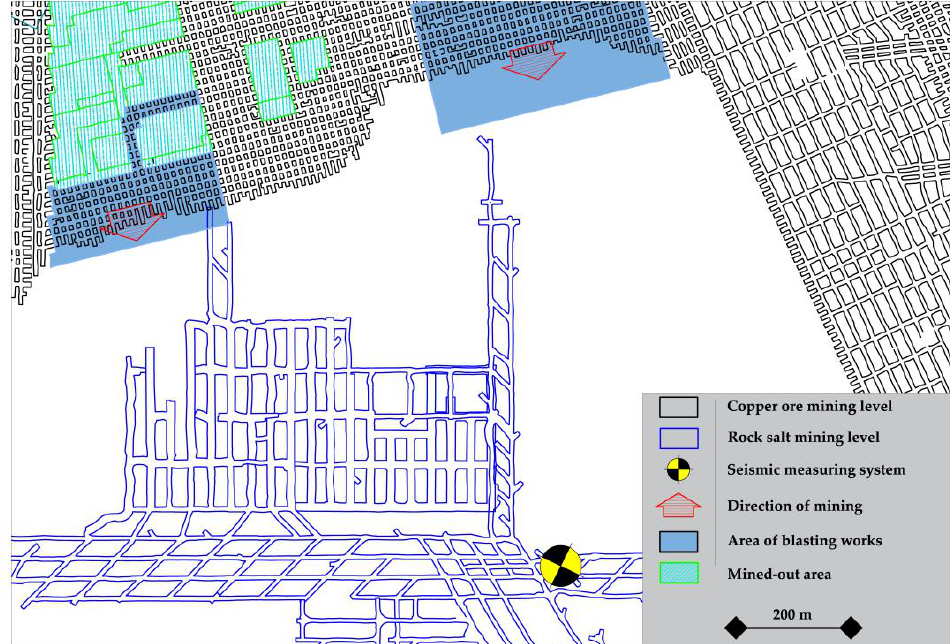
Figure 5. Location of blasting site in relation to monitoring system.